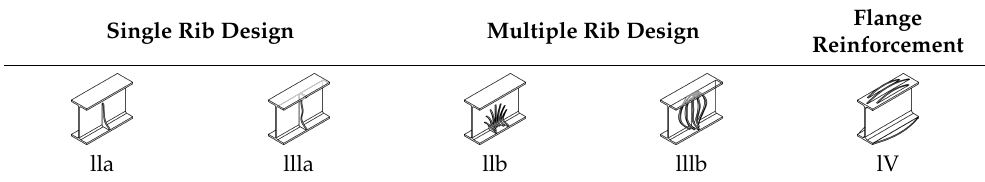
Table 1. Names of demonstrator objects.